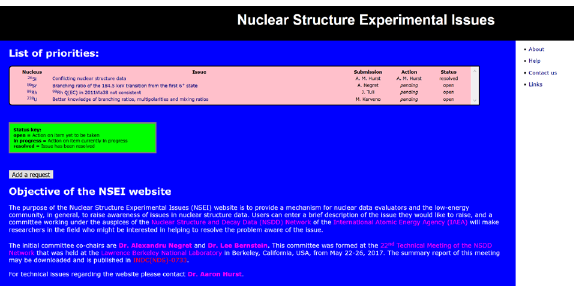
Figure 1. Nuclear Structure Experimental Issues Database inter- face: https: // nucleardata.berkeley.edu / hpnsrl / .